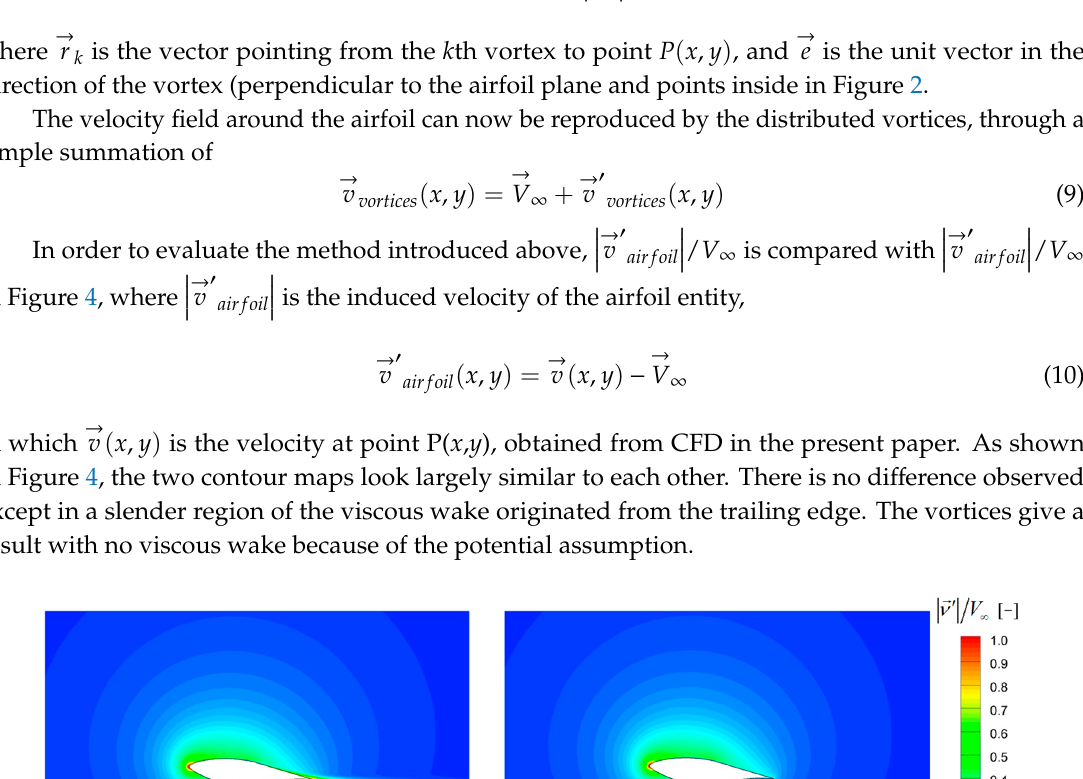
(cid:12) (cid:12) (cid:48) → ′  (cid:12) (cid:12) v V ; (cid:12) (cid:12) v ∞ (cid:12) / V ∞ ; (cid:12) airfoil airfoil